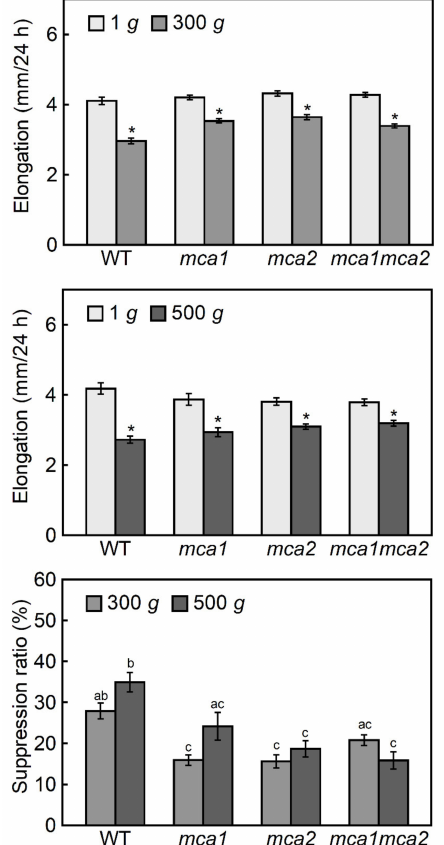
Figure 3. E ff ects of hypergravity on the elongation growth of hypocotyls in mca -null mutants. Wild type (WT) and mca -null mutants were grown at 25 ◦ C for 48 h at 1 g . The seedlings were then transferred to 1 g , 300 g , or 500 g conditions and grown for an additional 24 h at 25 ◦ C. The length of the hypocotyls was measured using a scale. Values are means ± SE ( n = 20). Upper, elongation under 1 g or 300 g conditions after 24 h growth. Middle, elongation under 1 g or 500 g conditions after 24 h growth. * Mean value with a significant di ff erence between the 1 g and hypergravity treatments in each line (Student’s t- test: p < 0.05). Lower, suppression ratio (the di ff erence between the elongation under 1 g and hypergravity conditions was shown as a percentage of the 1 g value). Di ff erent letters above the bars represent statistically significant di ff erences (Tukey’s HSD test: p <